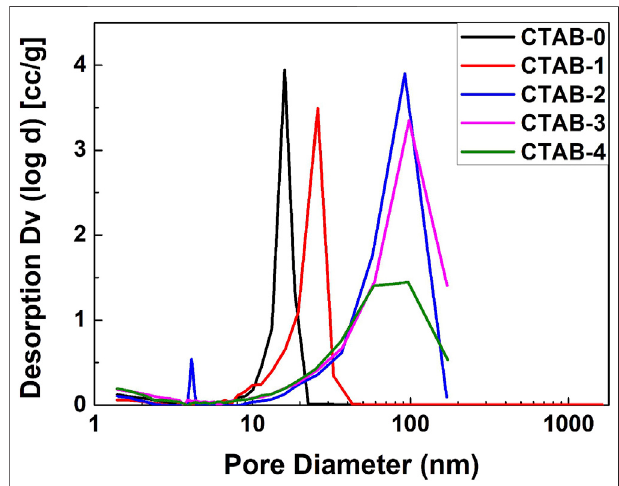
FIGURE 5 | Comparison of the pore size